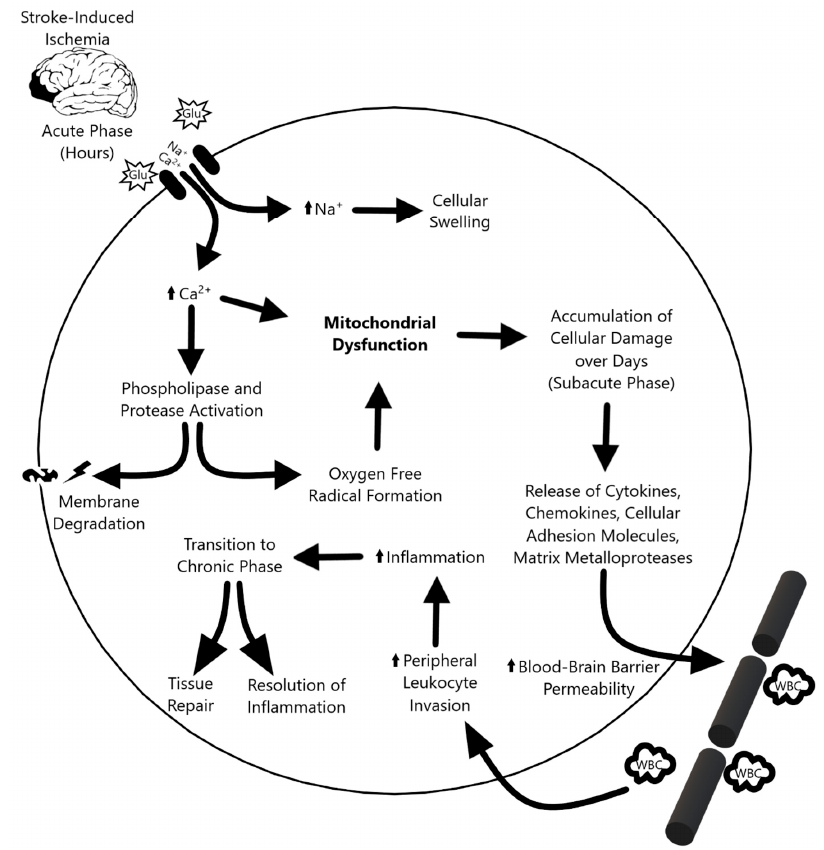
Figure 1. Overview of the three phases of the ischemic cascade. The acute phase following stroke-induced damaged precipitates ionic imbalances that ultimately propagate mitochondrial dysfunction. This progresses to subacute phase-based cellular damage, leukocyte invasion, and inflammation. Inflammation dissipates in the chronic phase, which culminates in tissue repair.